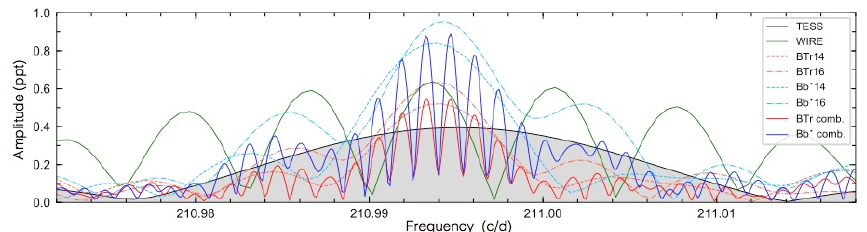
Figure 20. Fourier amplitude spectra of the TESS, WIRE and BRITE photometry, centred on the main pulsation frequency ( f 1 ) of α Cir. BTr14, BTr16, Bb (cid:63) 14, and Bb (cid:63) 16 are the red and blue BRITE data, obtained during the years 2014 and 2016, respectively. Bb (cid:63) represents the combined blue data obtained with BRITE-Austria and BRITE-Lem. The BRITE-blue amplitudes are divided by two (!!) for better comparison with the other data (adapted Figure6 of Weiss et al.